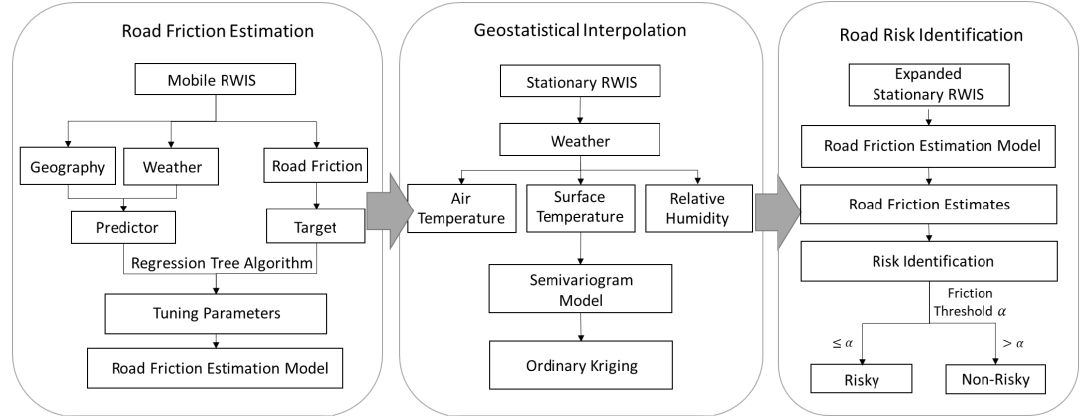
Figure 2. A schematic diagram of the proposed method.